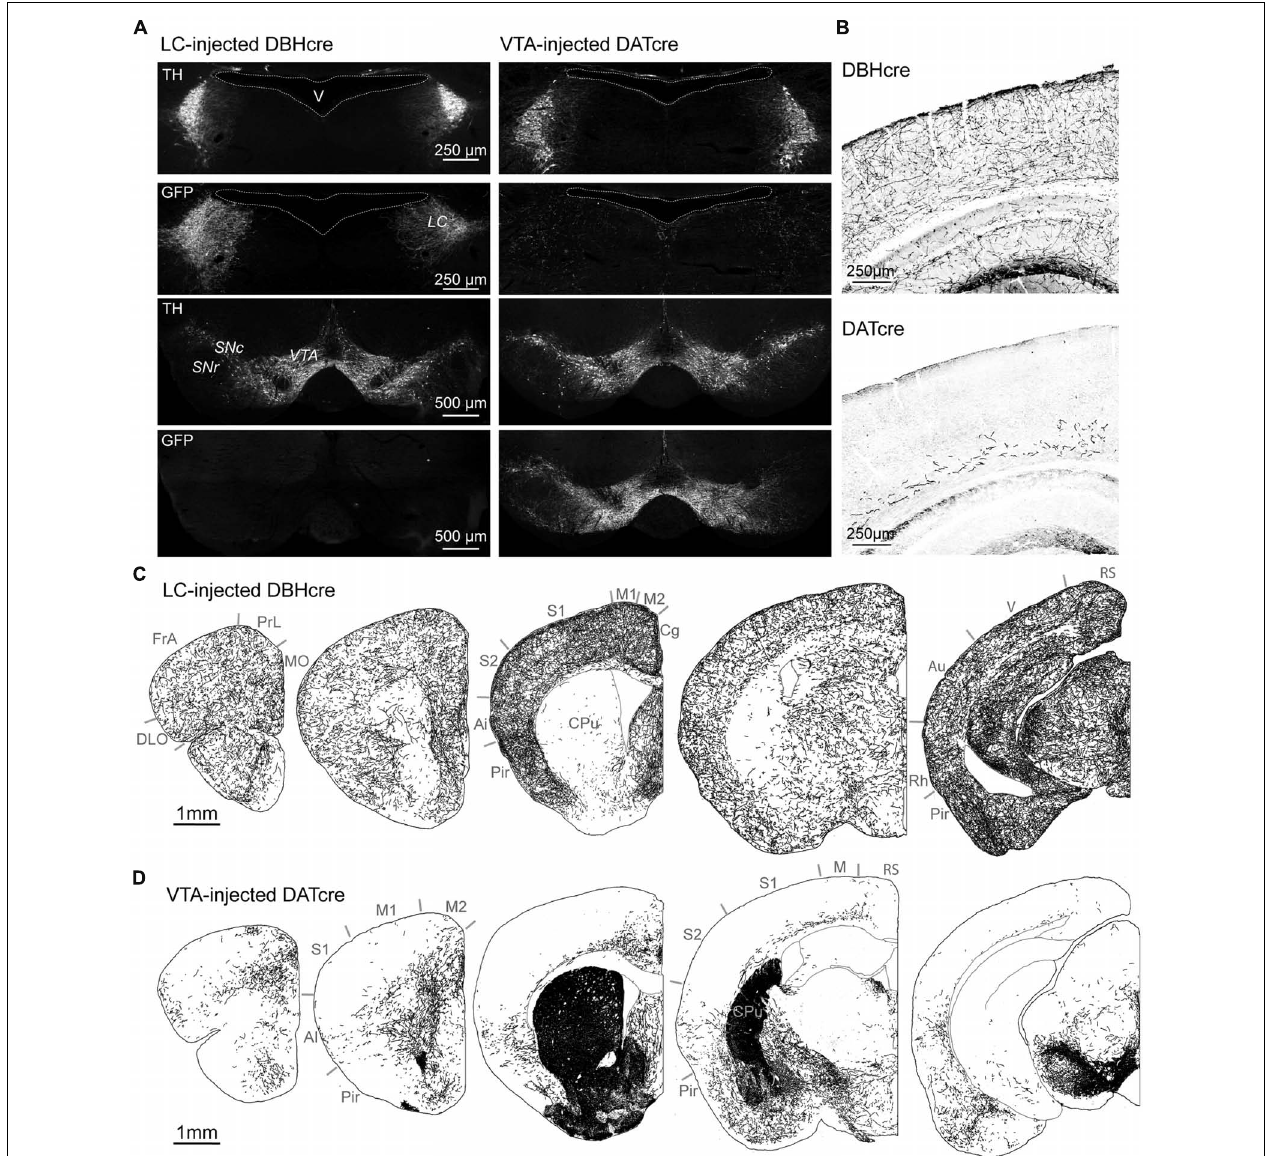
FIGURE 1 | Catecholaminergic projections to the cortex. (A) Immuno- labeling againstTH and GFP in the LC andVTA 8 weeks after bilateral injection of a Cre-dependent AAV expressing GFP in the LC of DBH-Cre mice or the VTA of DAT-Cre mice. Note that GFP labeling inVTA-injected DAT-Cre mice extends to neighbor DA neurons of the substantia nigra pars compacta (SNc) but is absent from NA neurons of the LC. (B) Immunolabeling of GFP- expressing fibers in the somato-sensory parietal cortex of DBH-Cre and DAT-Cre mice. (C,D) Drawings of NA or DA fibers obtained from